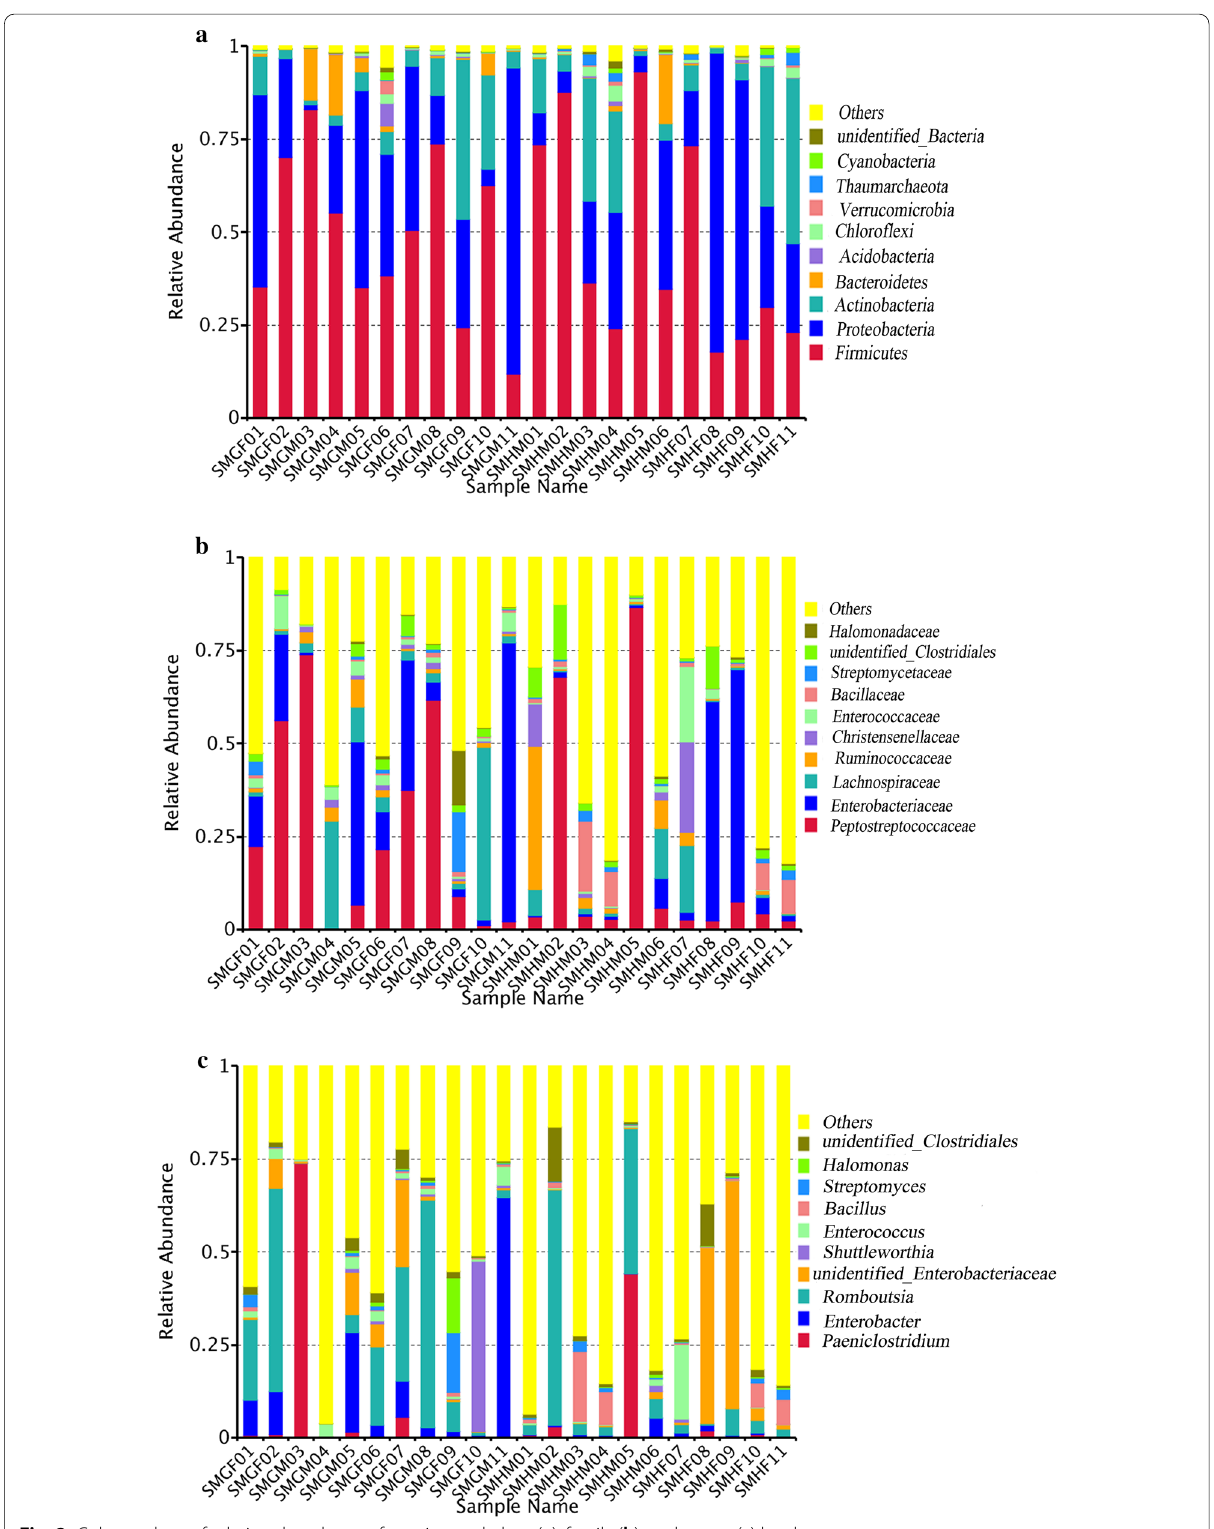
Fig. 2 Column chart of relative abundance of species at phylum ( a ), family ( b ), and genus ( c )